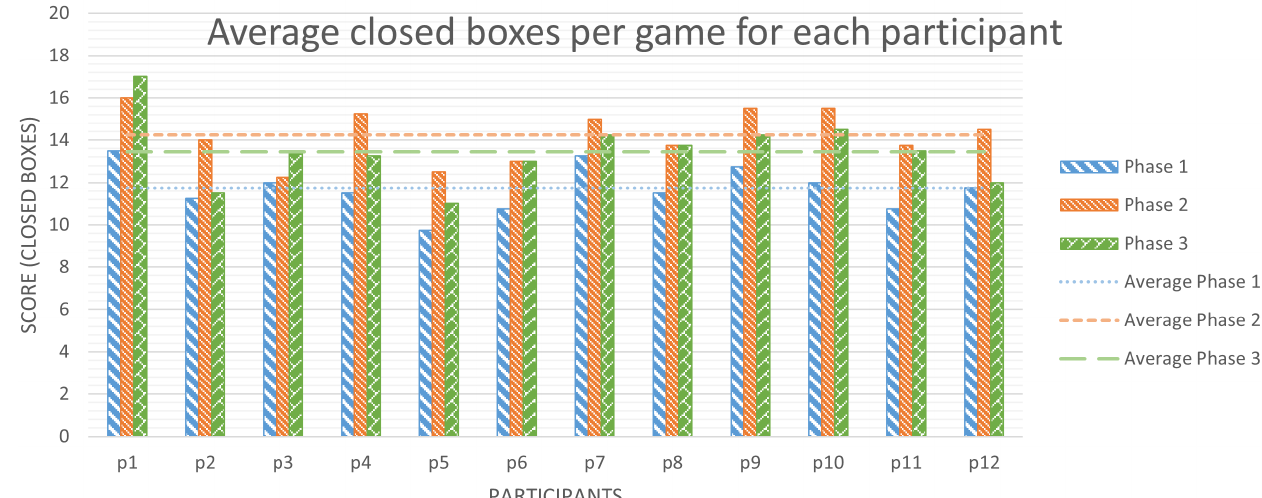
Figure 7. Average boxes scored per game for every player in each phase.